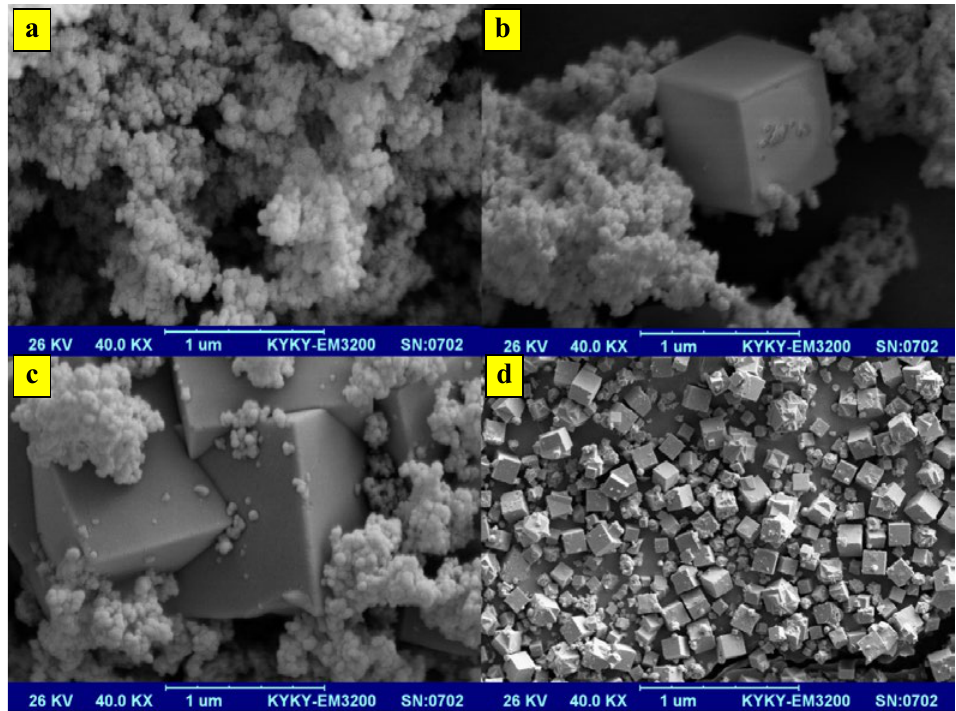
Fig. 2: SEM images of samples synthesized at 90 o C at different hydrothermal time. (a) 30 h,(b) 48 h, (c) 72 h, (d) 96